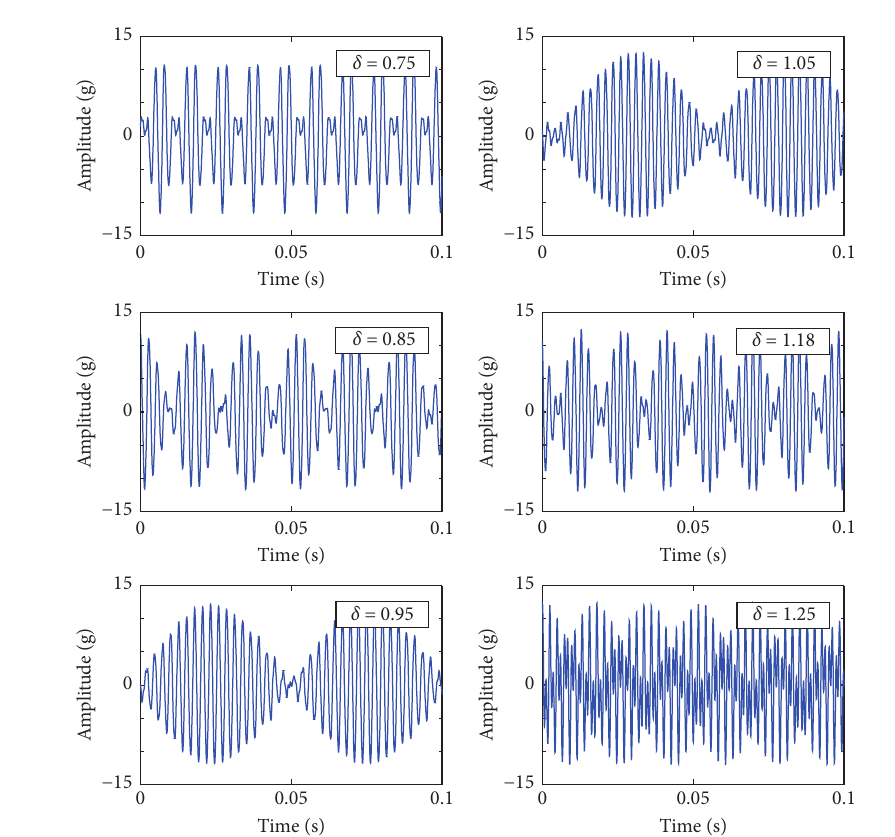
Figure 10: Variation of the beat vibration according to frequency